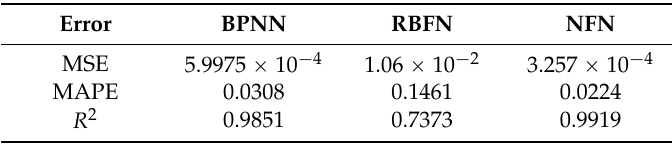
Table 5. Error comparison with BPNN, RBFN and